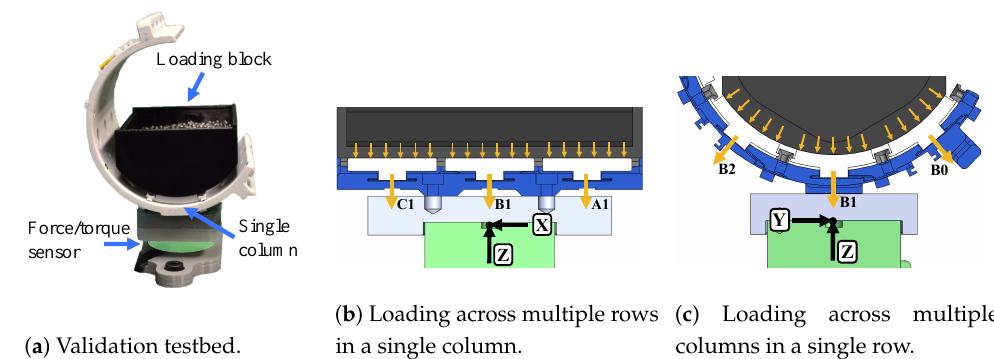
Figure 7. The validation testbed with the sensorized cuff mounted on a six-axis force/torque sensor (green). Distributed forces are applied with the loading block (black).